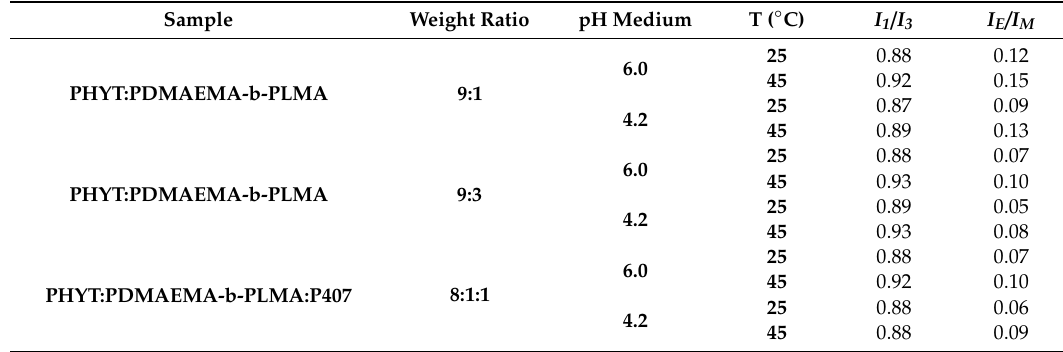
Table 7. Fluorescence intensity ratios I 1 / I 3 (indicating micropolarity) and I E / I M (indicating microfluidity) for a pyrene probe incorporated in the PHYT prepared